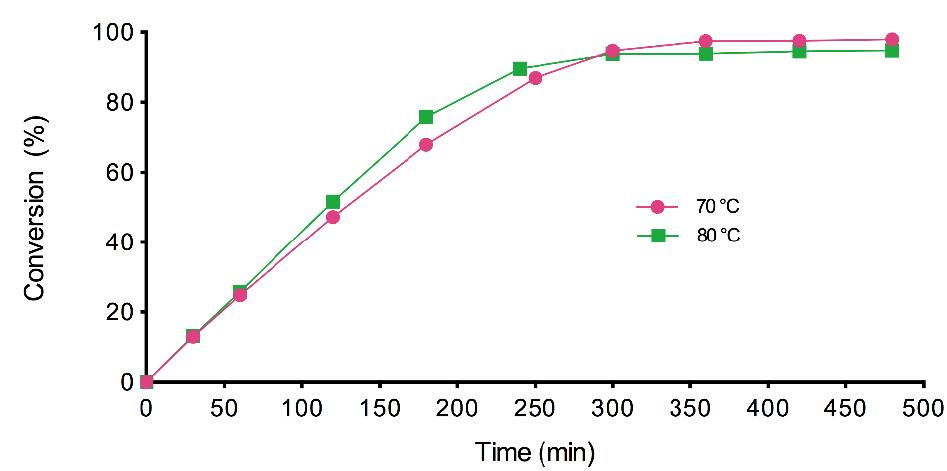
Figure 4. Conversion values of EHMH with time at 70 ◦ C and 80 ◦ C, 350 rpm, 2.5% ( w/w ) of biocatalyst and 10% EH molar excess (1:1.1 substrate molar ratio).